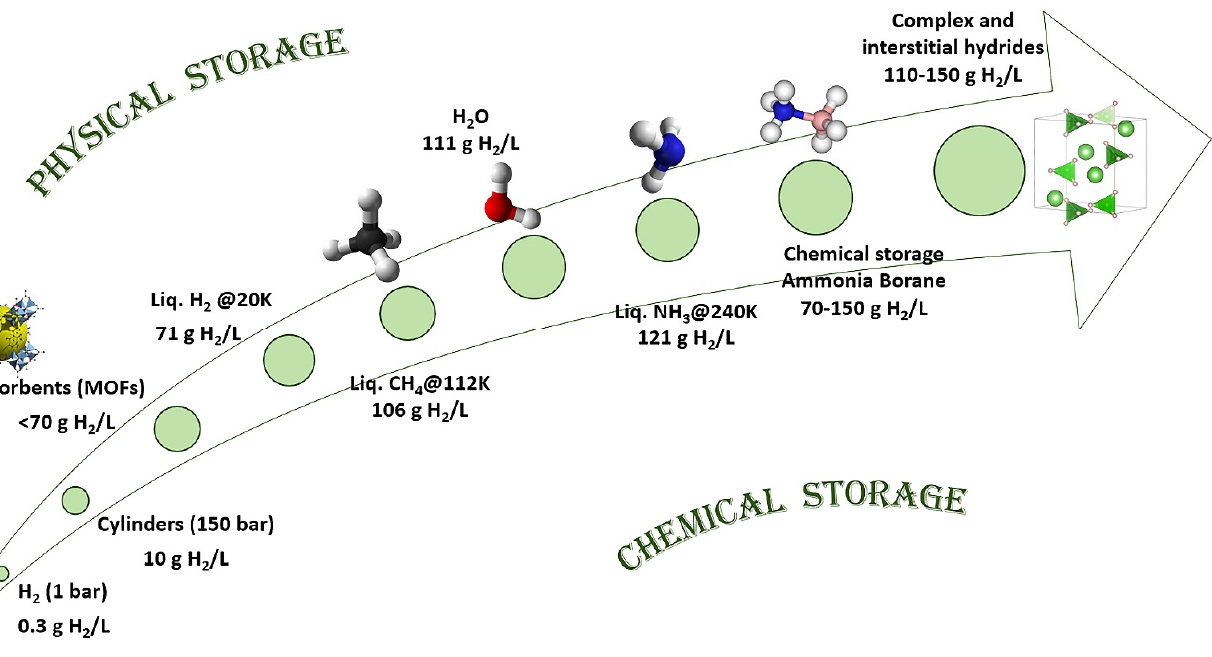
Figure 2. Compressed versus material-based hydrogen storage, arranged by increasing gravimetric